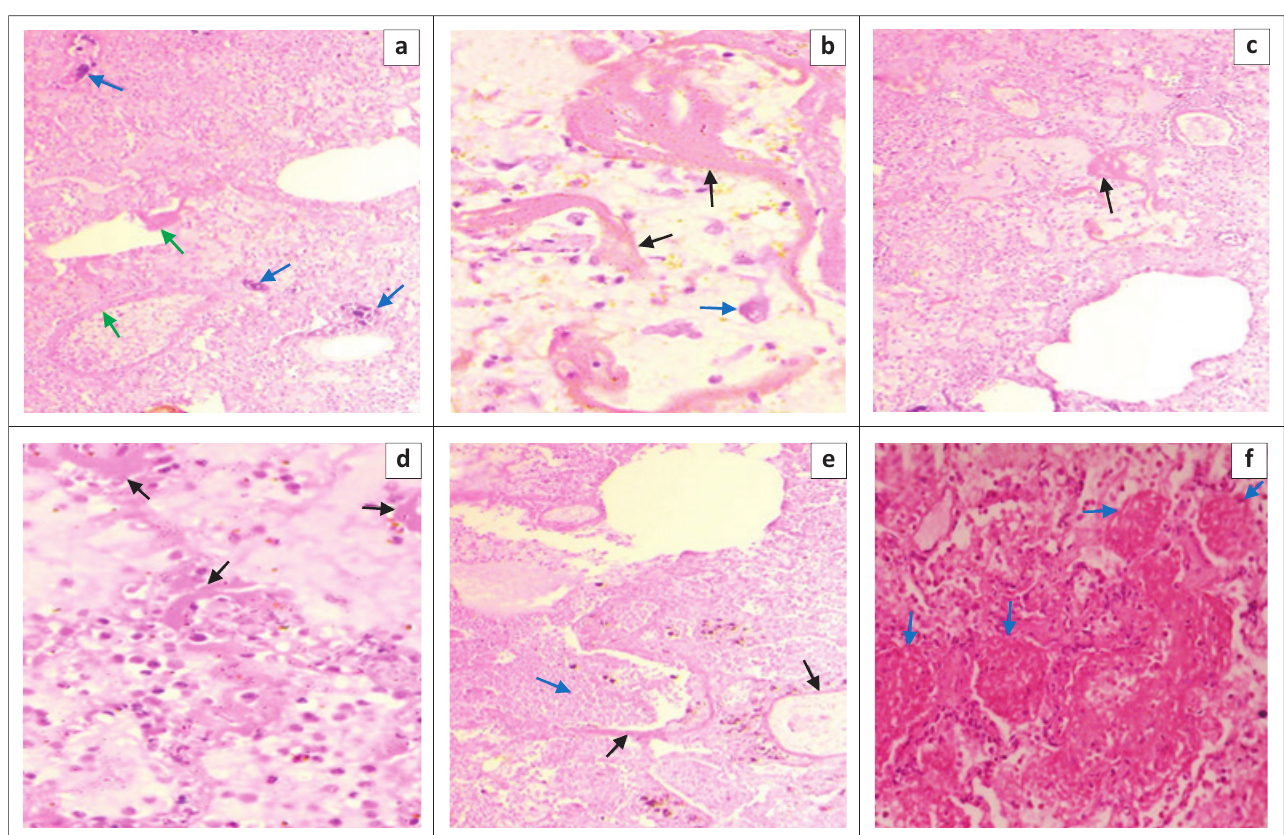
FIGURE 1: Haematoxylin and eosin staining of lung tissue samples from a 38 year old male patient presumed to have COVID-19 (37 Military Hospital, Accra, Ghana, April 2020). Case 1: (a) Autolytic changes with bacterial colonization in the smaller airways (blue arrows) ×100. Diffuse alveolar damage is noted with hyaline membrane formation (green arrows) ×100. (b) Higher magnification showing hyaline membrane (black arrows) and alveolar macrophages (blue arrow) ×400. (c) Diffuse alveolar damage with prominent hyaline membrane formation (black arrow) ×100. (d) Hyaline membrane formation (black arrows) ×400. (e) Pneumonic changes with mixed inflammatory cells exudate (blue arrow). Hyaline membrane (black arrow) ×100. (f) Area of microthrombi in smaller pulmonary capillaries ×400.